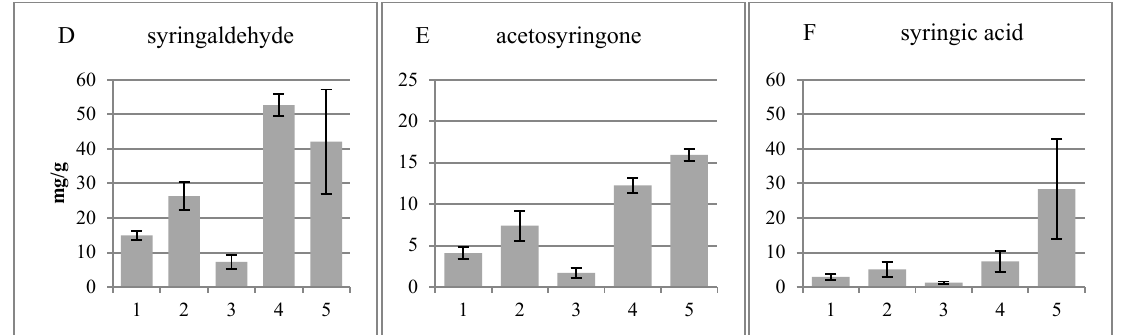
Figure 2. Guaiacyl ( A – C ) and syringyl ( D – F ) units released by the CuO treatment of the different tissues analyzed with the GC-MS. 1, Cork cambium; 2, non-conductive phloem; 3, combined conductive phloem, cambium and differentiating xylem; 4, lignified xylem; 5, previous year’s xylem.